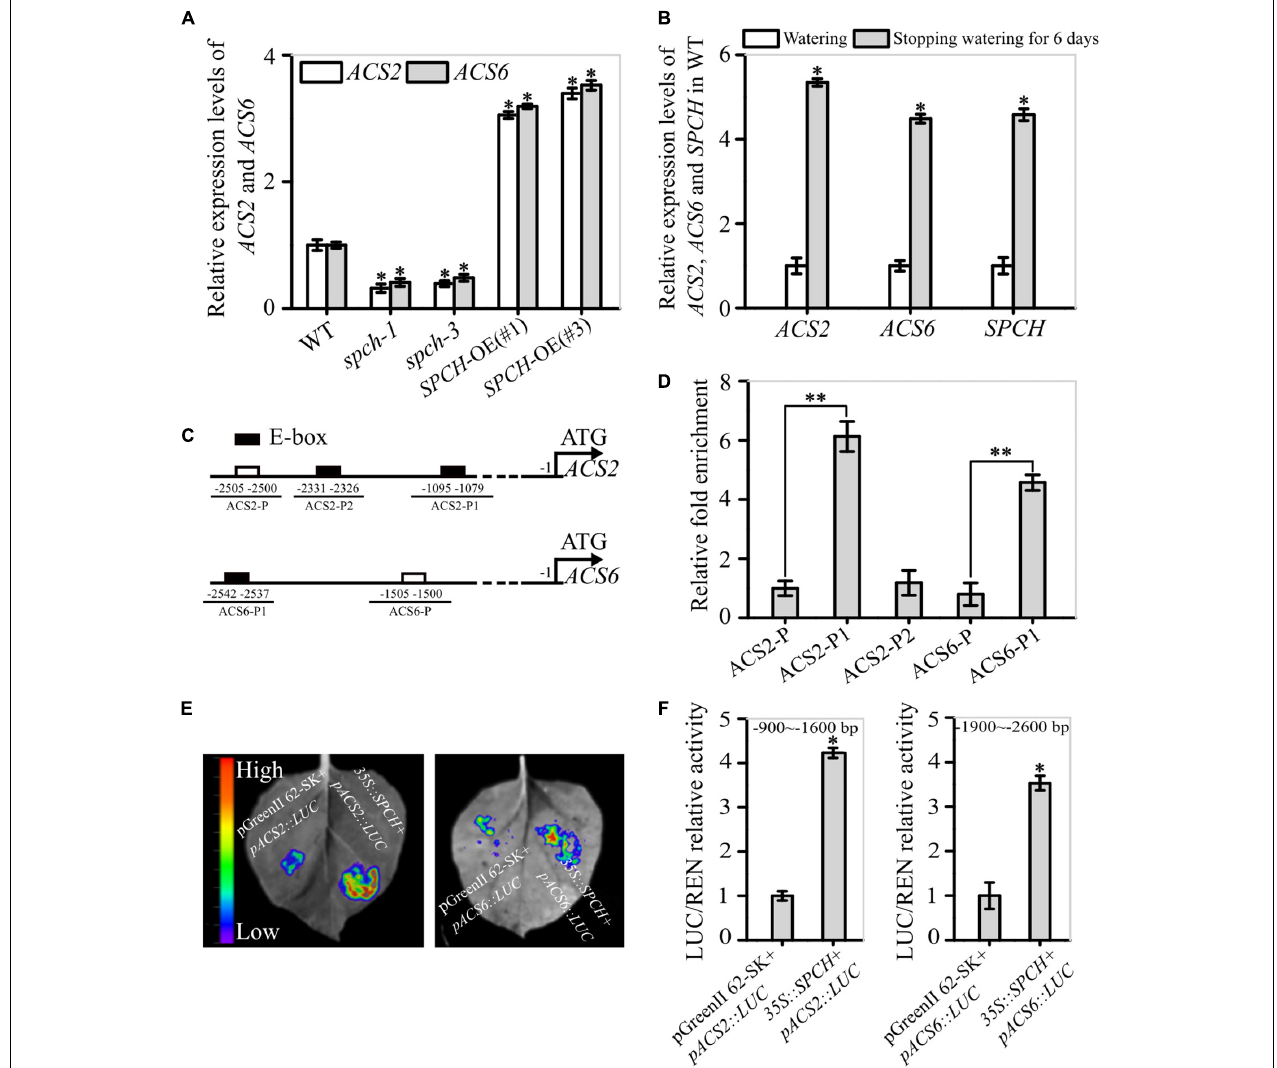
FIGURE 4 | Evidence for the function of SPCH as a transcription factor of ACS2 and ACS6 genes. (A) Levels of ACS2 and ACS6 mRNA in immature leaves of WT control, loss-of-function spch-1 and spch-3 mutant, and SPCH -overexpressing plants of SPCH -OE(#1) and SPCH -OE(#3) based on RT-qPCR. Experiments were repeated three times with similar results. Values are means ± SD (Student’s t -test; ∗ P < 0.05). (B) Relative levels of ACS2 , ACS6 , and SPCH mRNA transcripts in leaves of 21-day-old WT seedlings under normal watering conditions or after 6 days without watering. Experiments were repeated three times with consistent results. Values are means ± SD (Student’s t -test; ∗ P < 0.05). (C) Diagram of the relative position of E-boxes (CACGTG or CGCGTG) and a reference DNA region in ACS2 and ACS6 gene promoters. Black rectangles indicate E-boxes in ACS2 (ACS2-P1 and ACS2-P2) and ACS6 (ACS6-P1) promoter regions, while